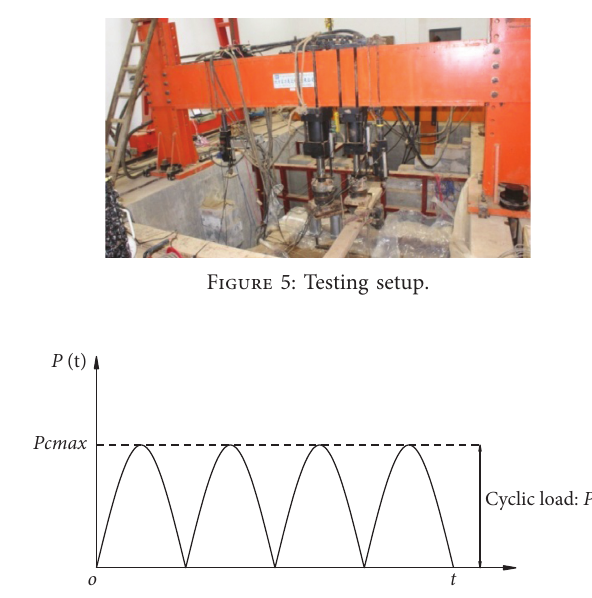
Figure 6: Dynamic loading